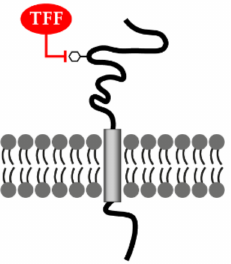
Figure 4. Lectin-triggered receptor blocking hypothesis. TFF peptides could negatively interfere with the binding of the natural ligand(s) after binding as lectins to the carbohydrate moiety (hexagon) of various glycosylated transmembrane